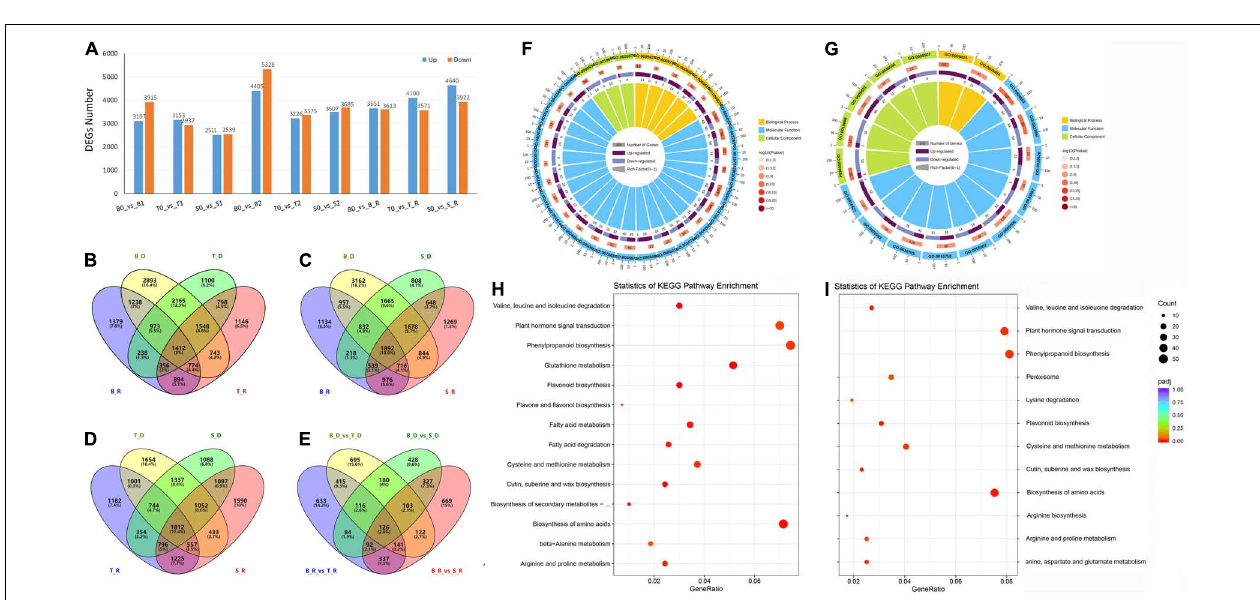
FIGURE 3 | The activity of enzymes related to ROS scavenging and MDA content of EC_S1, Tadmor and Baudin after drought treatment. (A) SOD activity; (B) POD activity; (C) CAT activity; (D) MDA content. * and ** indicate significance levels at P ≤ 0.05 and 0.01, respectively ( n = 3 independent replicates).